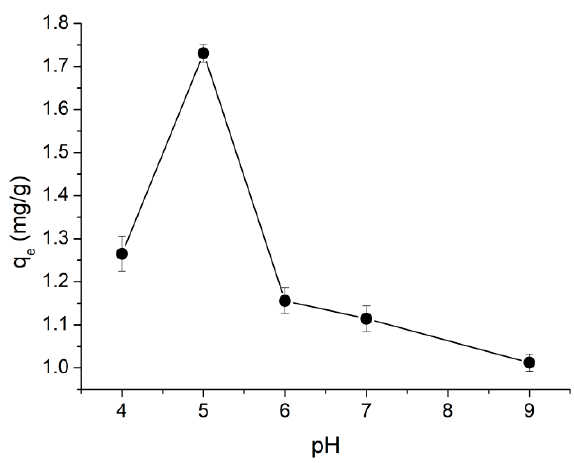
Figure 2. BPA equilibrium adsorption capacity q e as a function of pH. Experimental conditions: fiber loading = 1 g; water volume = 100 mL; C 0 = 30 mg/L; water matrix = UP.